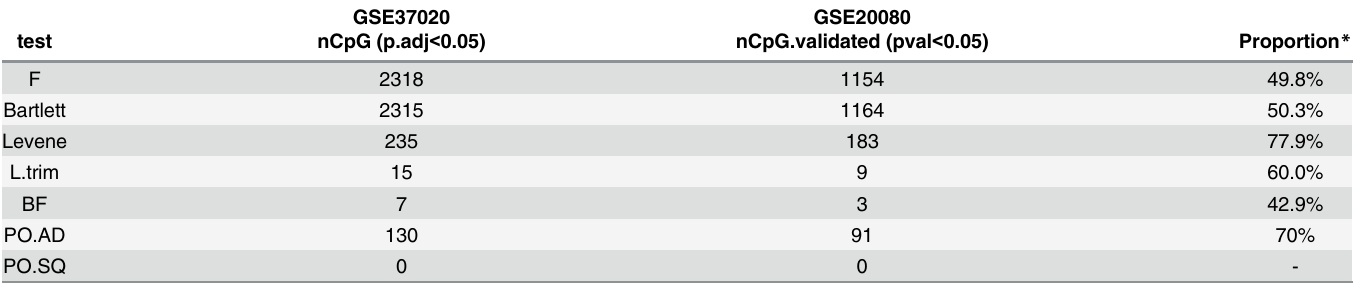
Table 2. Number of significant CpG sites (FDR-adjusted p-value < 0.05) in testing for equality of variance based on GSE37020, and the numbers and proportions of significant CpG sites validated via GSE20080 (unadjusted p-value < 0.05). Total number of CpG sites is 22859.